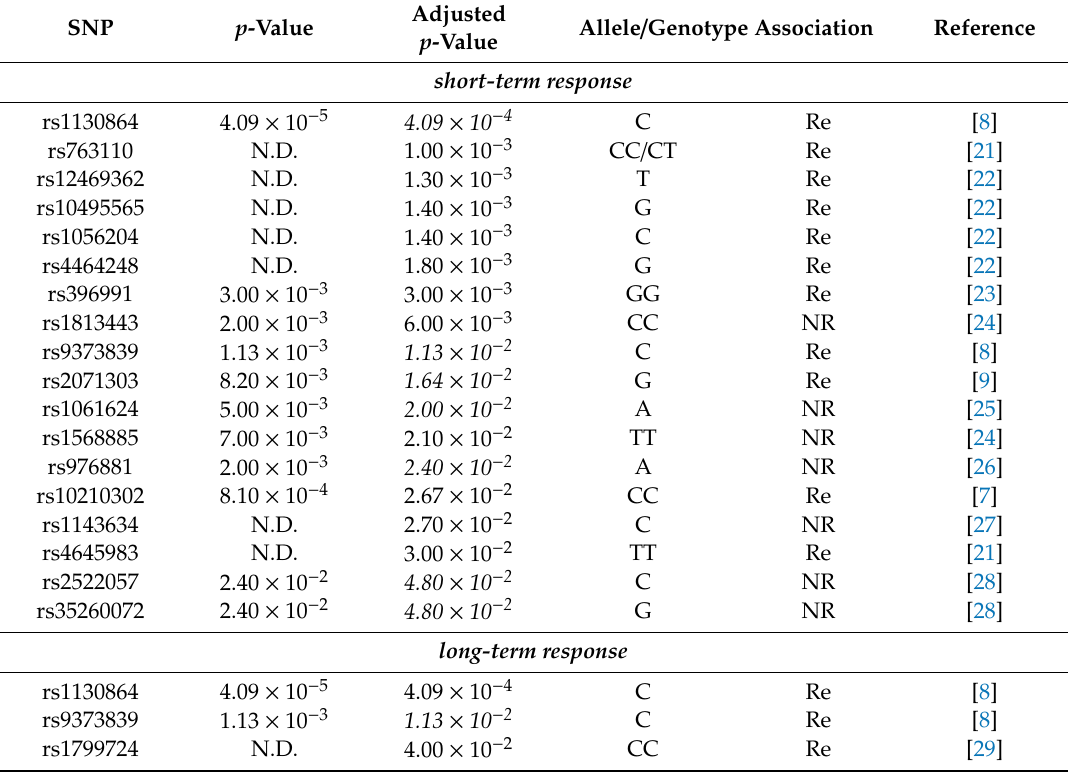
Table 1. Single-Nucleotide Polymorphisms (SNPs) linked to anti-TNF response in CD patients with adjusted p <